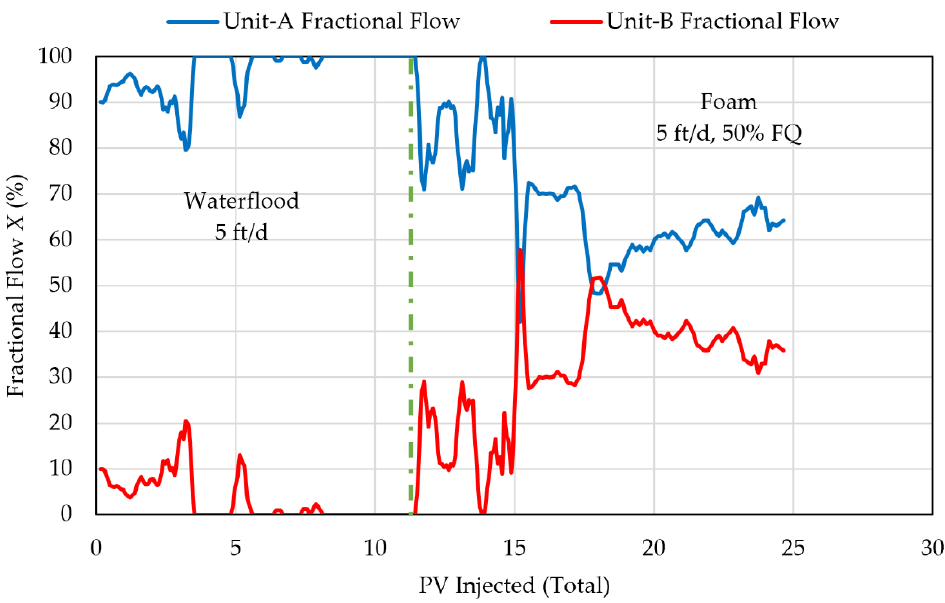
Figure 12. Fractional flow through Unit-A and Unit-B cores for DI-Exp 2.